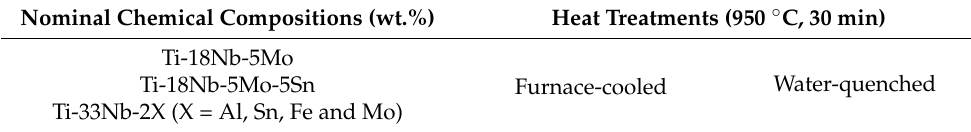
Table 1. The nominal chemical compositions and heat treatments. Nominal Chemical Compositions